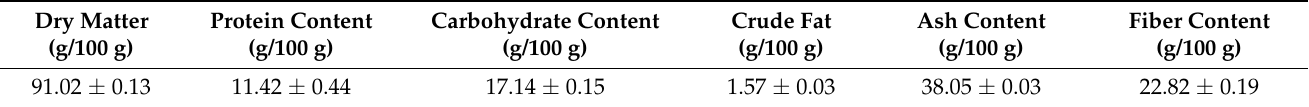
Table 1. Proximate composition of dried giant kelp ( M. pyrifera ). Units in the table are in g compounds per 100 g dry weight (DW) macroalgal powder. Results are expressed as average ± standard deviation ( n = 3).